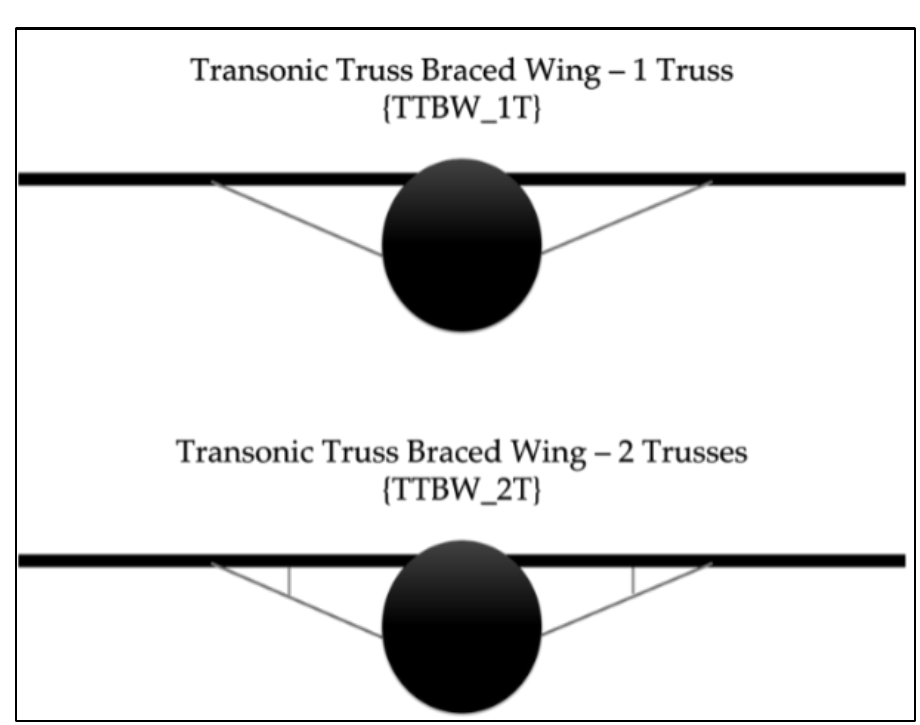
Figure 2. Schematic of TTBW_1T (top figure) and TTBW_2T (bottom figure).